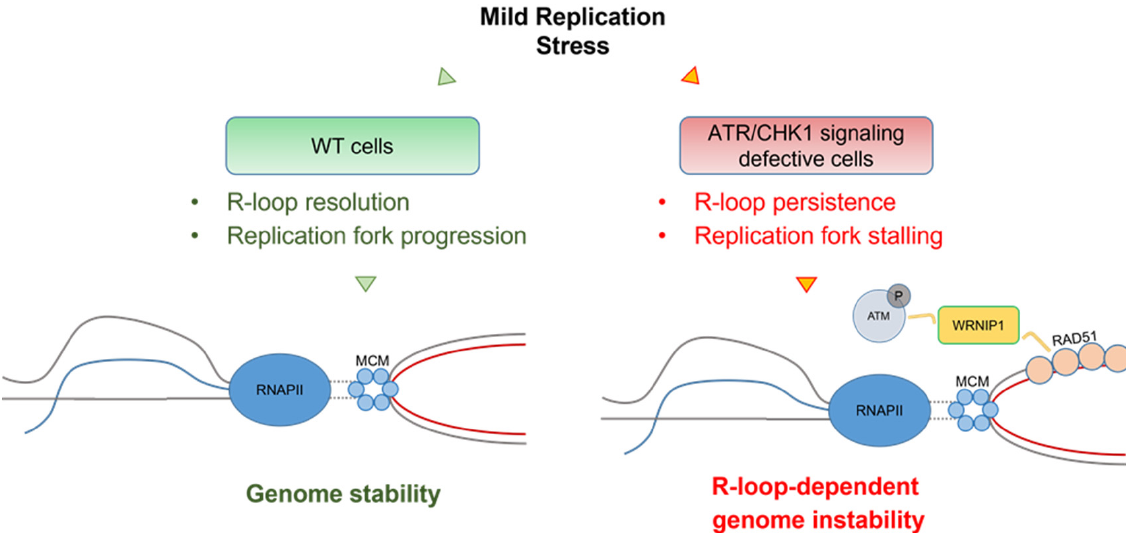
Figure 4. Model of the role of the WRNIP1-mediated response in counteracting R-loop-associated genome instability in cells with a dysfunctional ATR checkpoint. Following aphidicolin-induced mild replication stress in wild-type cells, proficient R-loop resolution allows proper replication fork progression, thus, ensuring genome integrity. Conversely, a defective ATR checkpoint causes R-loop persistence leading to TRCs. In this context, WRNIP1 could stabilise RAD51 at R-loops or R-loop- dependent stalled forks and contribute to the activation of the ATM pathway to repair downstream DSBs derived from the active processing of R-loops and collisions with the forks. Therefore, a dual function of WRNIP1 is required for proper maintenance of genome stability in the pathological contexts deriving from a dysfunctional ATR-dependent